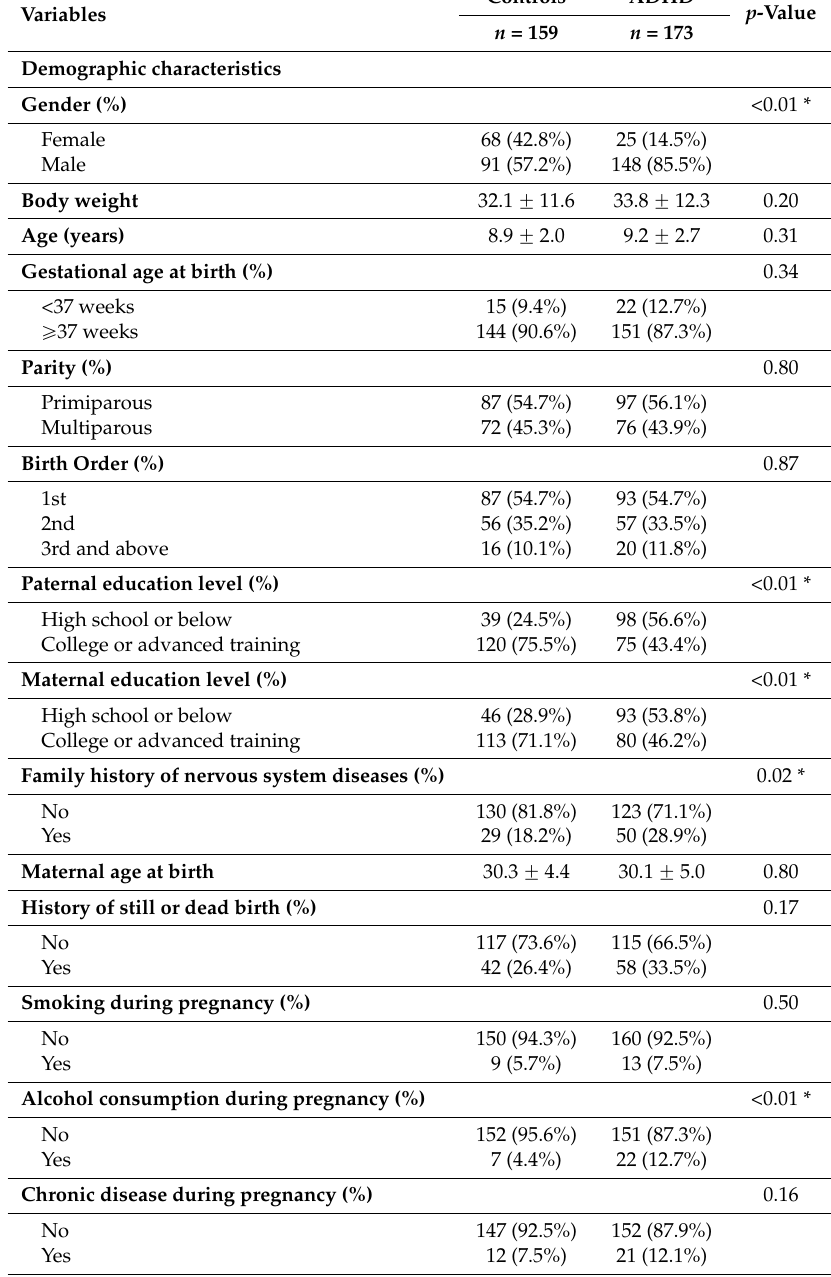
Table 1. Demographic characteristics of the study participants ( N =